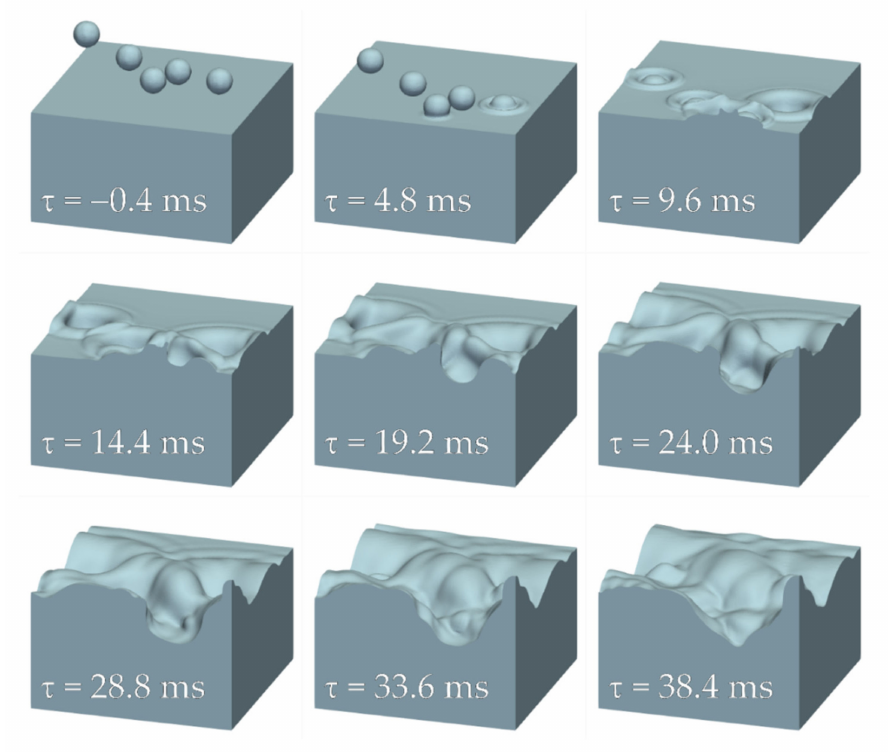
Figure 3. Examples of frames (3D and 2D used to extract the crater depth) showing the evolution of the craters and of the free surface of the pool for a case of multiple drop impacts with 5 drops, impact velocity 1.4